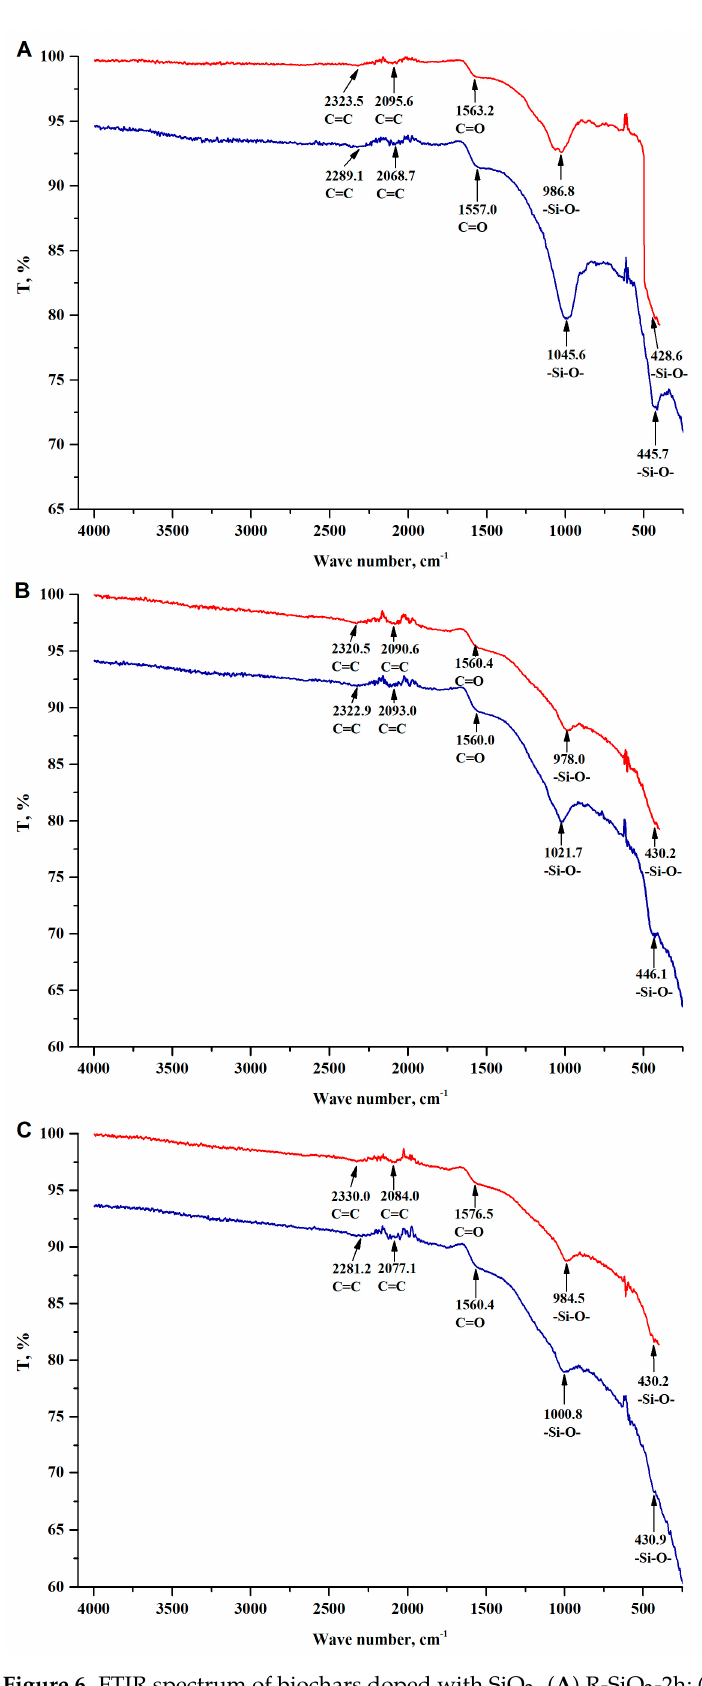
Figure 6. FTIR spectrum of biochars doped with SiO 2 . ( A ) R-SiO 2 -2h; ( B ) R-SiO 2 -4h; ( C ) R-SiO 2 -6h; before sorption—red line; after copper(II) sorption—blue line.